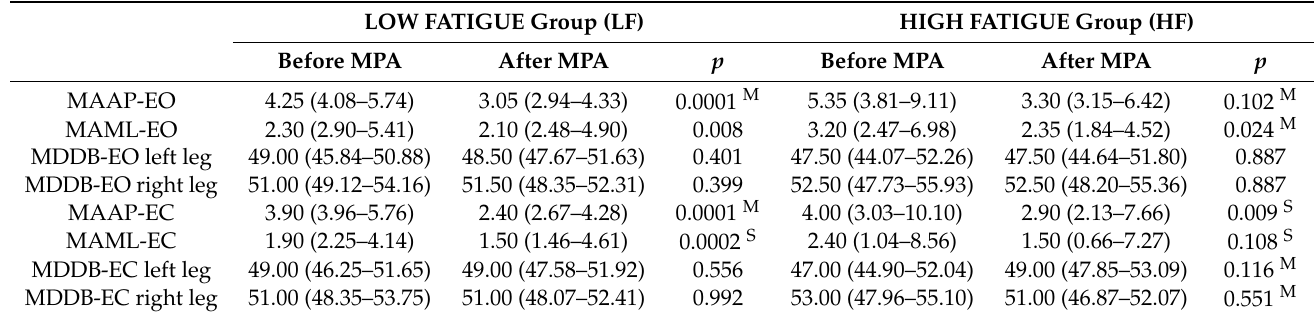
Table 3. The influence of MPA on MS patients with LF and HF using a stabilometric platform.